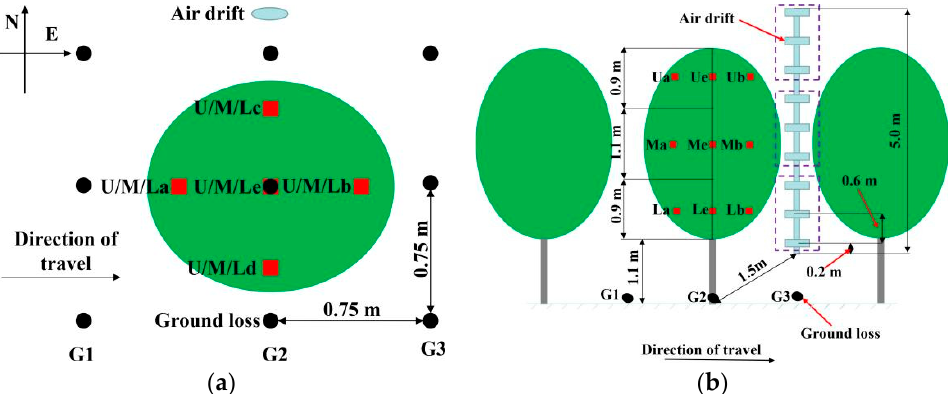
Figure 14. Sample layout design. ( b ) shows the schematic diagram that was used to test the air drift. In this case, the direction of the wind during the test was blowing from the test fruit tree to the collection pole with a wind speed magnitude of 1.0–2.0 m/s. ( a ) Top view; ( b ) right view.